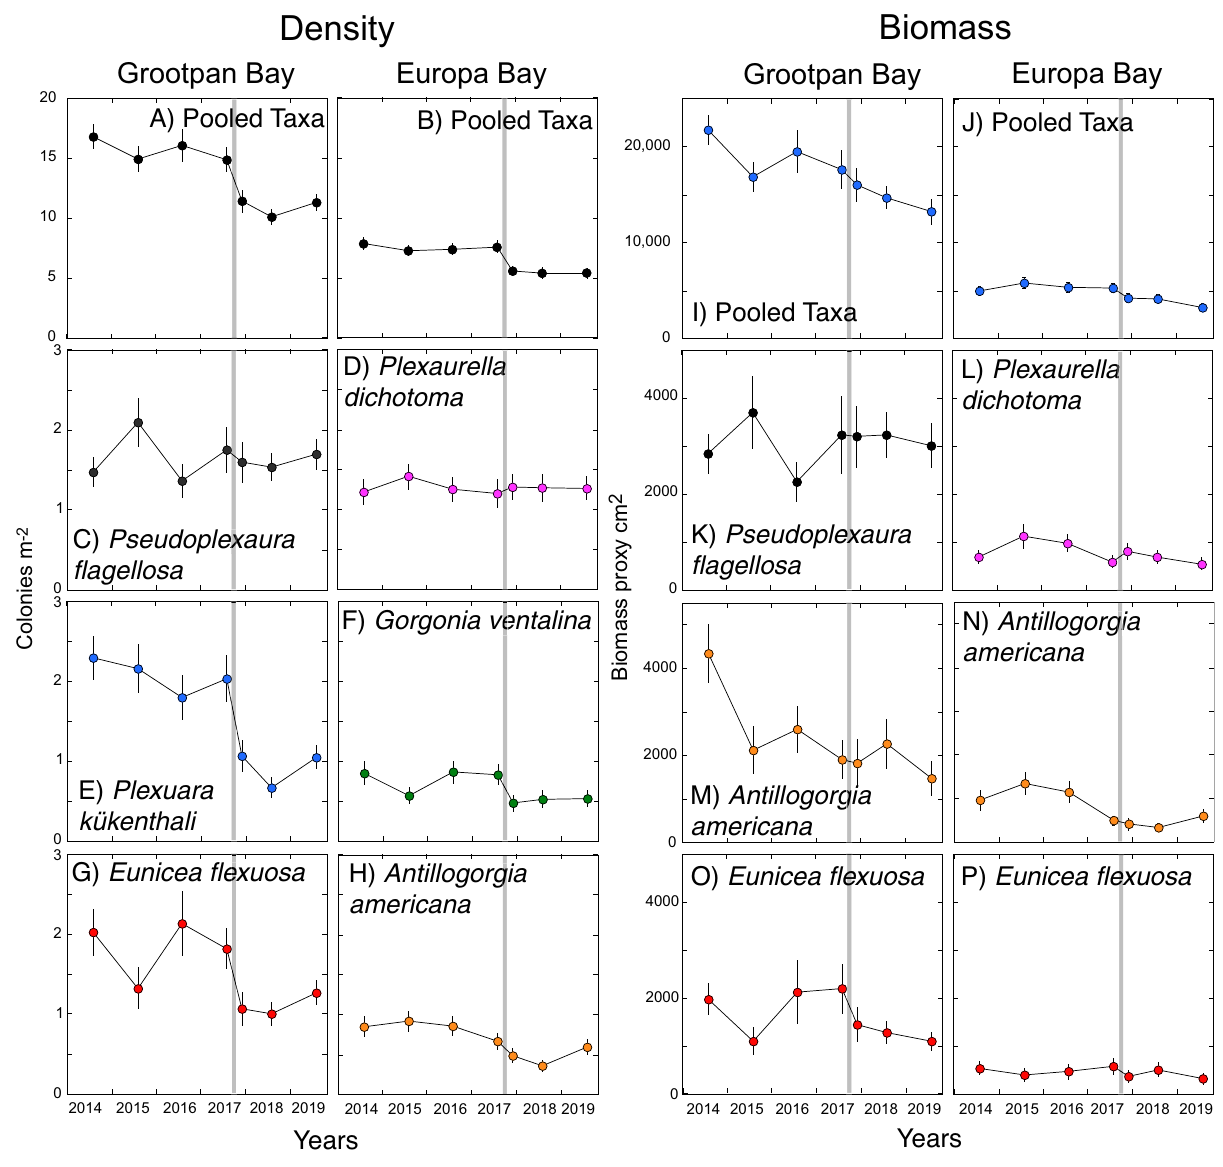
Figure 1. Octocoral community structure (density, colonies m −2 , and biomass proxy, cm 2 ) at Grootpan Bay and Europa Bay from 2014 to 2019. Values show mean ± SE (n = 28–60 quadrats) for pooled taxa ( A , B and I , J ) and the three most common taxa by density ( C – H ) and the biomass proxy ( K – P ). Gray bars show the impact of Hurricanes Irma and